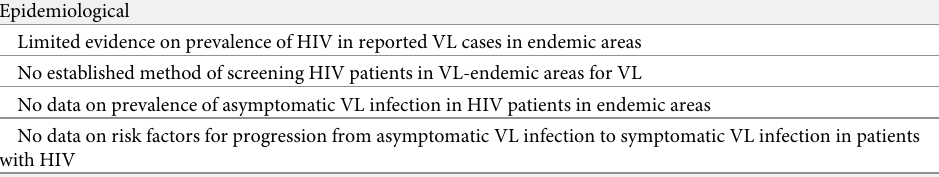
Table 3. Challenges in VL–HIV infection in Asia. Epidemiological Limited evidence on prevalence of HIV in reported VL cases in endemic areas No established method of screening HIV patients in VL-endemic areas for VL No data on prevalence of asymptomatic VL infection in HIV patients in endemic areas No data on risk factors for progression from asymptomatic VL infection to symptomatic VL infection in patients with HIV Diagnostic No evidence on the accuracy of existing RDTs for VL in coinfected patients Standard VL case definition unlikely to be appropriate for VL–HIV coinfected cases Improved biomarkers for confirming relapse need to be developed to reduce risk of repeated invasive biopsy Treatment No evidence for 40 mg/kg WHO recommended dose for VL–HIV infection in ISC Only observational data for lower doses of AmBisome and combination treatment No evidence on primary prophylaxis Limited evidence on secondary prophylaxis Very limited therapeutic options for treatment of VL in coinfection Challenge of VL–HIV–TB triple infection emerging and poorly understood